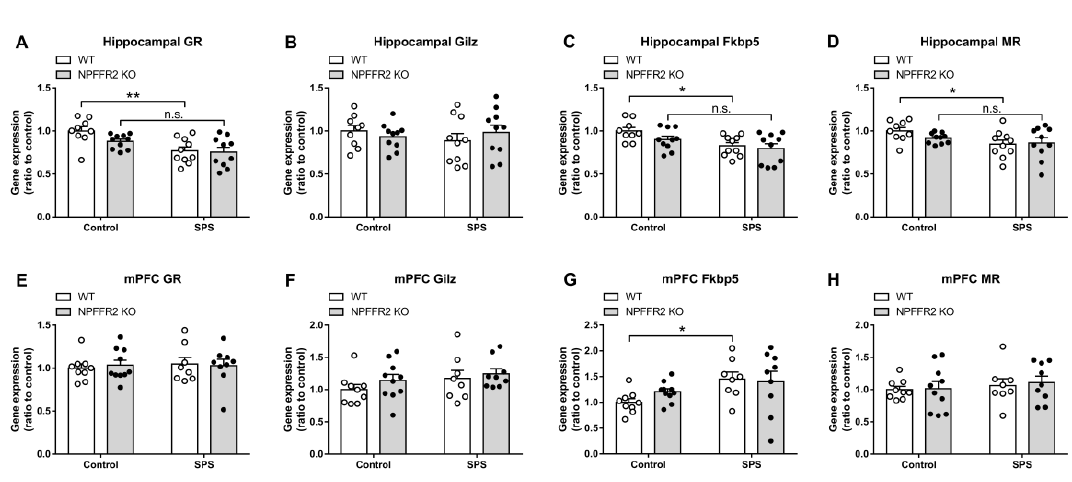
Figure 5. mRNA levels of glucocorticoid receptor (GR), GR-regulated genes and mineralocorticoid receptor (MR) in hippocampus and medial prefrontal cortex (mPFC) after SPS exposure. The hippocampus and mPFC of WT and NPFFR2 KO mice were collected from control and SPS-exposed mice, then analyzed for expression of the designated genes. ( A ) Hippocampal GR, ( B ) Hippocampal GC-Induced-Leucine-Zipper ( Gilz ), ( C ) Hippocampal FK506-binding protein 5 ( Fkbp5 ), and ( D ) Hippocampal MR (WT-control, n = 9; WT-SPS, n = 10; NPFFR2-KO control, n = 10; NPFFR2 KO-SPS, n = 10). ( E ) mPFC GR, ( F ) mPFC Gilz , ( G ) mPFC Fkbp5 and ( H ) mPFC MR (WT-control, n = 9; WT-SPS, n = 10; NPFFR2-KO control, n = 8; NPFFR2 KO-SPS, n = 9.). Data are represented as mean ± SEM and are analyzed by two-way ANOVA with Bonferroni’s multiple comparison test. * p < 0.05, ** p < 0.01, n.s., no significance; comparing control and SPS groups. The white and black dots indicate the individual value of WT and NPFFR2 KO mice, respectively.